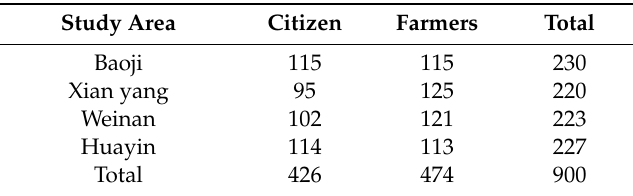
Table 2. Sample distribution in Wei River